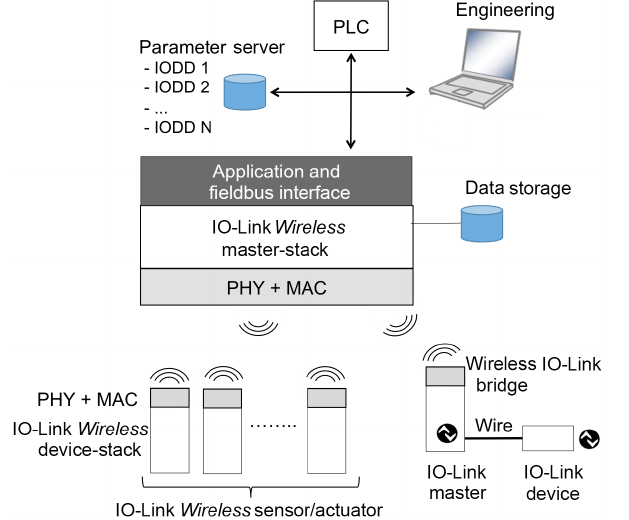
Figure 4. IO-Link Wireless system